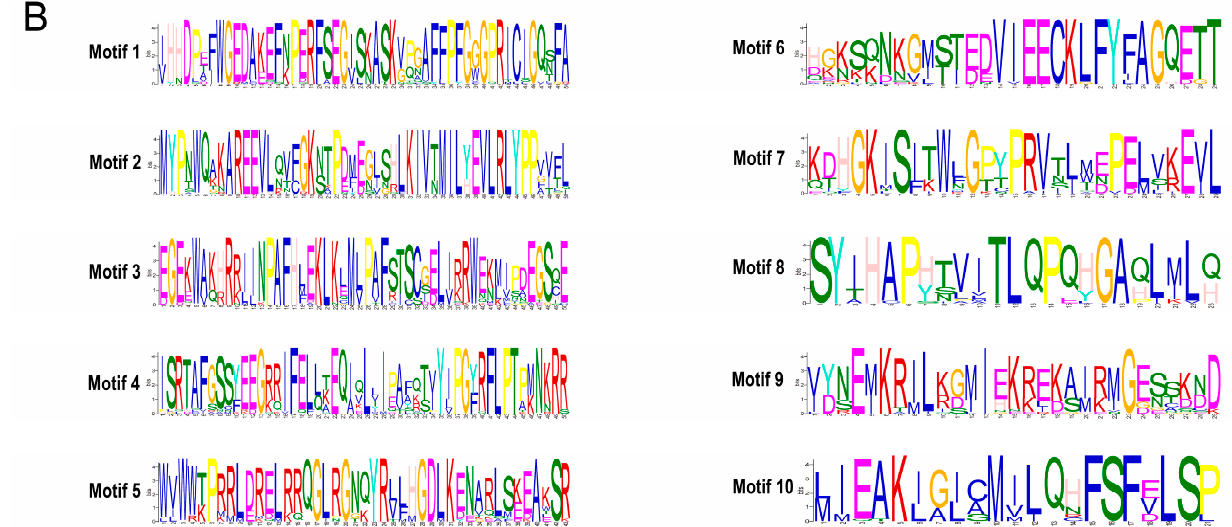
Figure 4. Motif pattern of DzCYP72As. ( A ) The motif composition of DzCYP72A proteins predicted by MEME and plotted in TBtools. The detailed information of ten motifs is exhibited by different colored boxes. The length of every DzCYP72A protein can be measured by the scale at the bottom. ( B ) Detailed information of ten motifs.